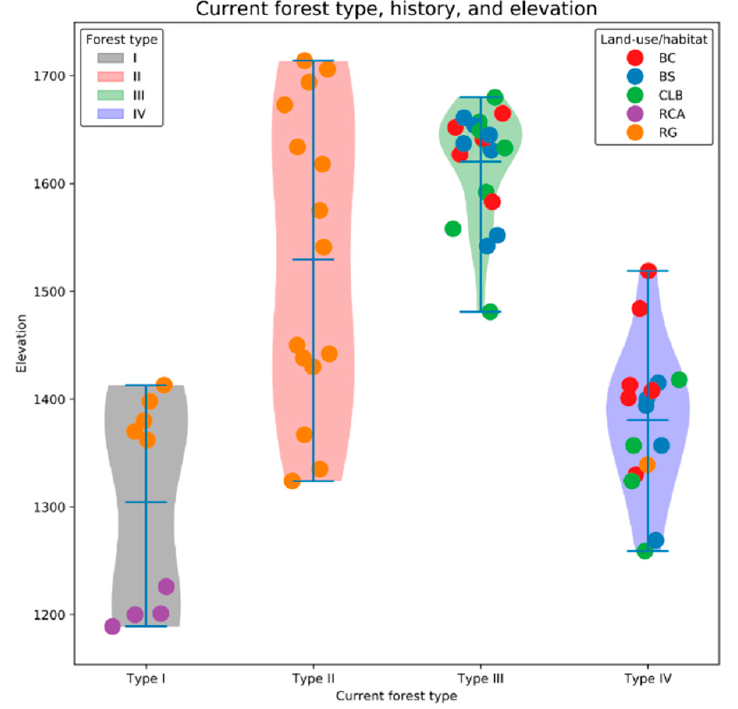
Figure 7. Current ecological state of sites (“forest type”) and their elevations. Historical land uses of sites are indicated by color of point fill.